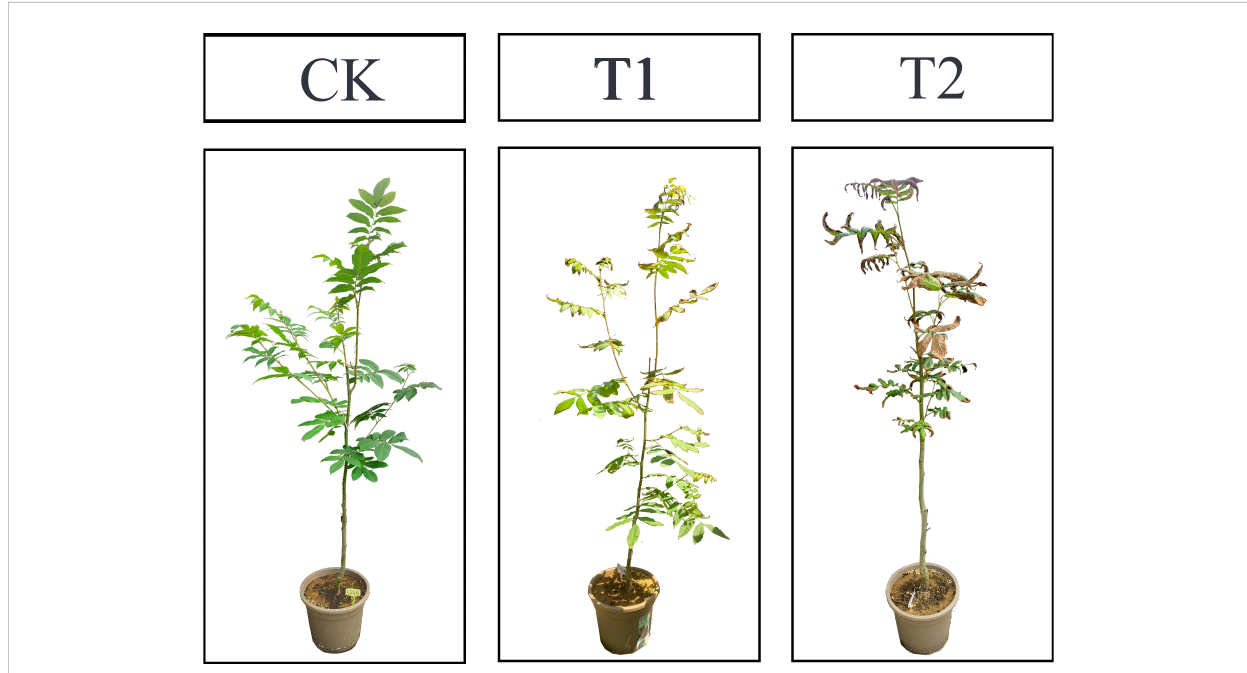
FIGURE 1 Phenotypes of C. paliurus seedlings at the sampling time under various salt treatments of the pot